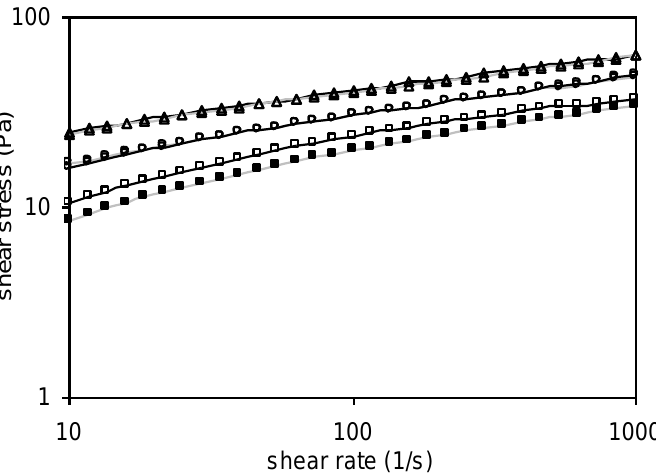
Figure 6. Hysteresis loops of the flow curves of Yanang gum at different temperatures. (open symbol = forward measurements and filled symbol = backward measurement); ( ∆ ) 5 ◦ C, (o) 25 ◦ C, ( (cid:3) ) 65 ◦ C. Table 4. Rheological parameter of the power low model of Yanang gum (1% w / v ) at different temperatures. Forward Temperature ( ◦ C)